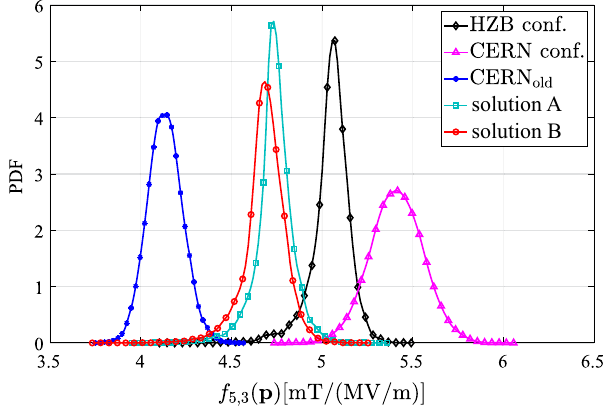
FIG. 14. Probabilistic density function for the ratio of the magnetic peak by the electric peak values.